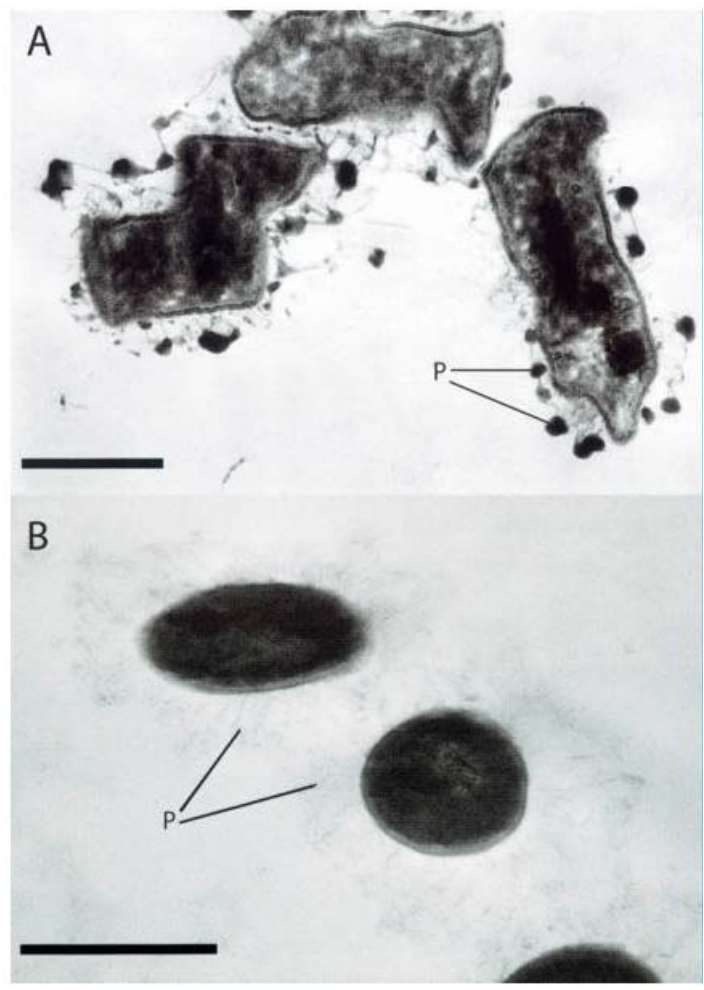
FIGURE 7. TEMs of thin-sectioned samples of the w-t . Cells stained with ruthenium red (A) appear pleomorphic and surrounded by a layer of clumped polymer (P). Cells stained with OsO 4 (B) appear to maintain their typical shape and are surrounded by a layer of polymer which, although it stained weakly, appear as a thick hair-like layer (P). Bar = 0.5